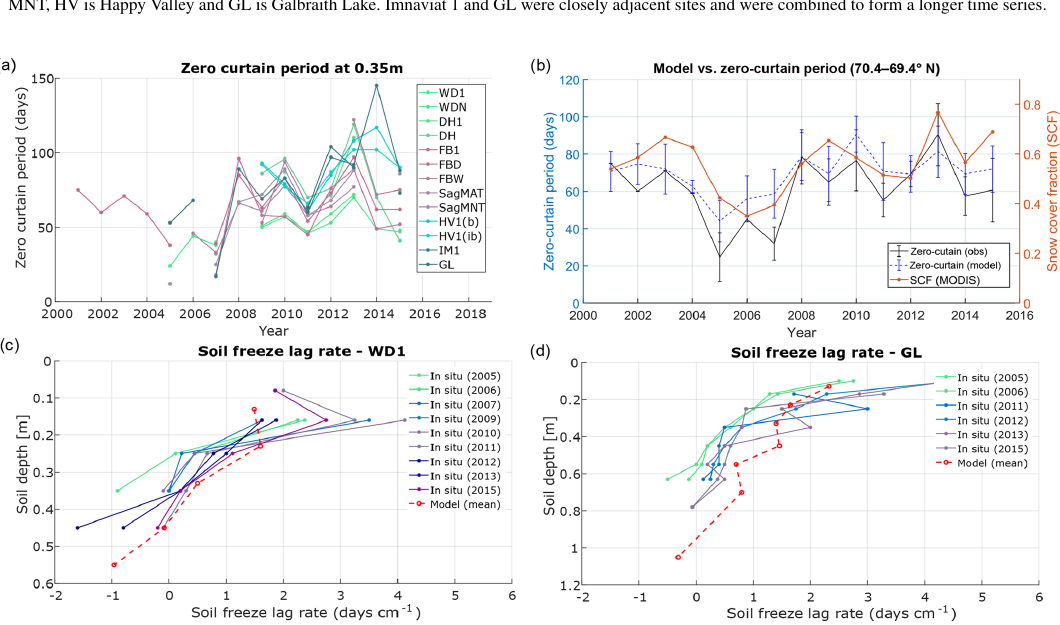
Figure 6. Comparisons of soil-freezing characteristics derived from GTN-P soil temperature measurements and model simulations along the DHN transect in northern Alaska: (a) interannual variations in zero-curtain period derived from in situ measurements, (b) variations of model versus in situ zero-curtain period at 0.35m soil depth relative to MODIS SCF averaged for the northern part of the DHN transect, (c, d) changes in the soil freeze lag rate with depth at two DHN sites. Both sites have lower ALT in the earlier years shown here, ranging from 0.37m in the earlier period to 0.43m during later period of record for the WD1 site and from 0.47 to 0.57m for the GL